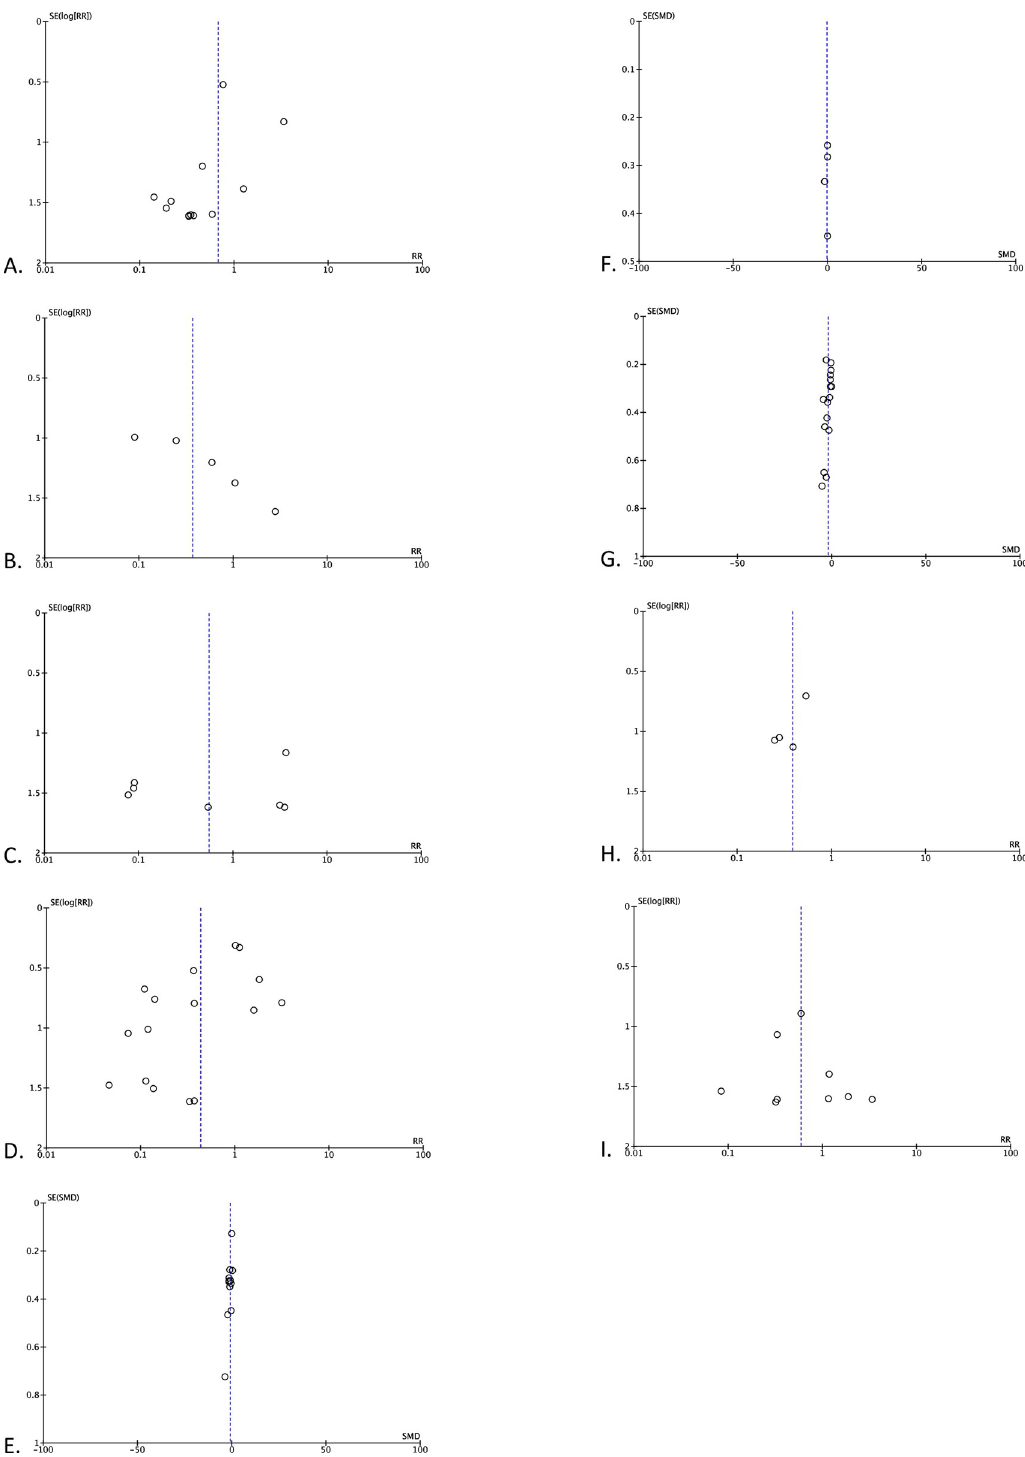
Fig 4. Funnel plots of (A) bile leakage, (B) wound infection, (C) pancreatitis, (D) overall postoperative complications, (E) operation time, (F) blood loss volume, (G) length of hospital stay, (H) readmission rate, and (I) reoperation rate.